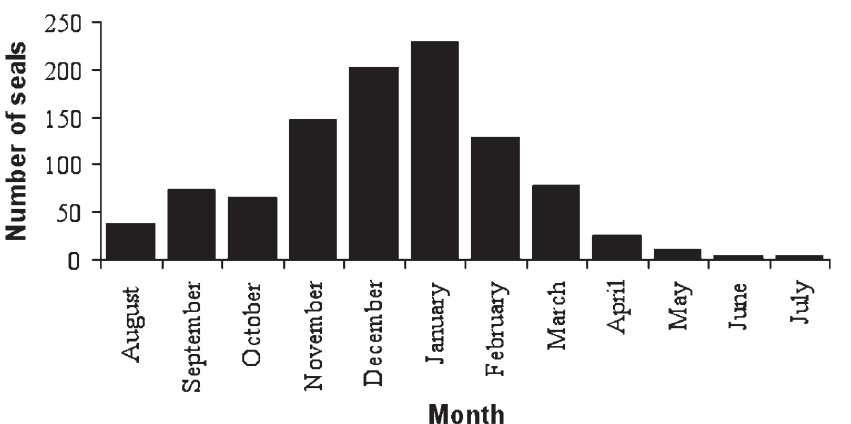
Fig. 6. Admitted seals diagnosed with a parasitic bronchopneumonia per month